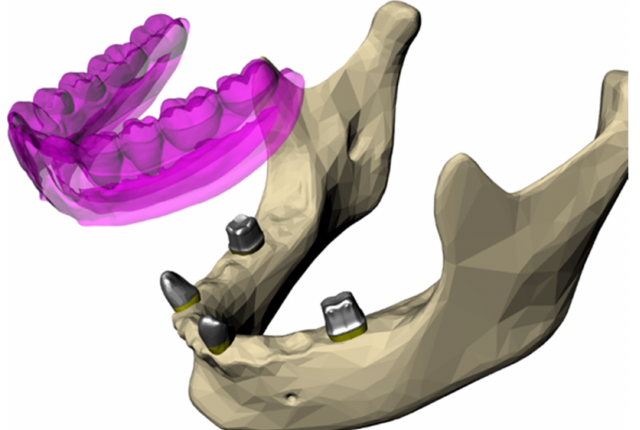
Figure 1. Schematic illustration showing the full-denture and the telescopic primary crowns in molar and canine abutment teeth.